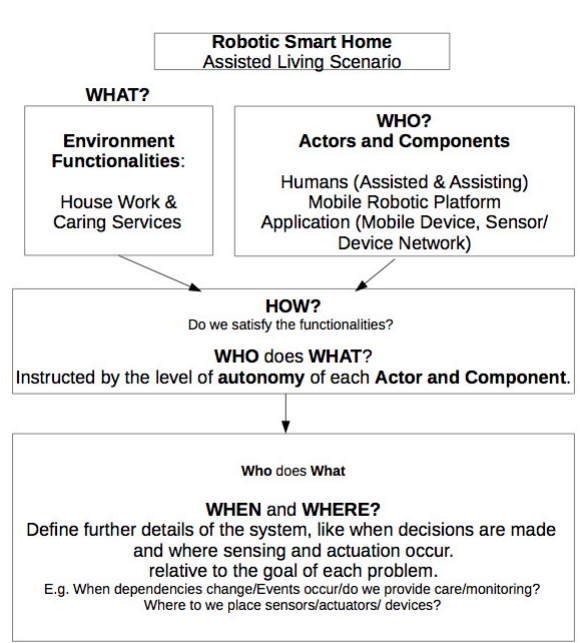
Figure 1. Conceptual Design of a Robotic Smart Home. The decisions are made in a top down